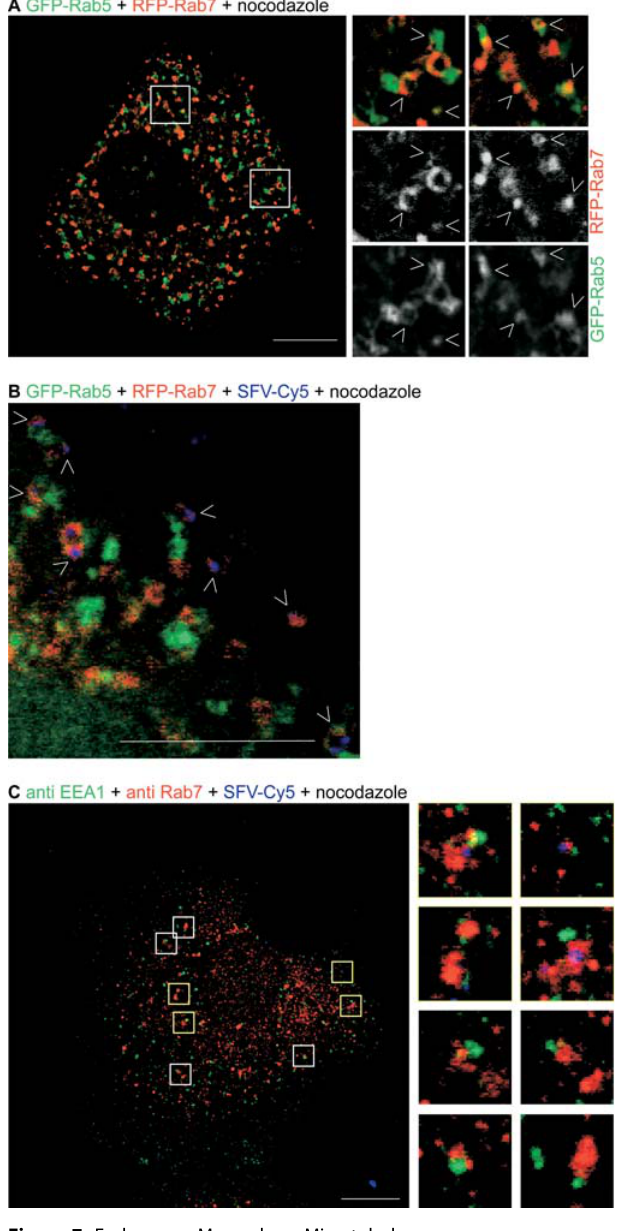
Figure 7. Endosomes Move along Microtubules (A) Confocal microscopy of a Vero cell transfected with GFP-Rab5 and RFP-Rab7 after treatment with 5 l M nocodazole. Endosomes are enlarged and many (approximately 75%) Rab5-positive endosomes are also positive for Rab7 (arrowheads). Scale bar represents 10 l m. (B) Cells treated as in (A) were incubated with SFV-Cy5, and fixed 1 h after warming. SFV-Cy5 is present in bigger endosomes positive for Rab5 and Rab7 (arrowheads). Scale bar represents 5 l m. (C) Confocal microscopy of a Vero cell treated with 5 l M nocodazole and incubated with SFV-Cy5. After 1 h of internalization at 37 8 C, cells were fixed, permeabilized, and immunostained for EEA1 and Rab7. Endosomes positive for both markers can be seen (white rectangles) (41%), and SFV- Cy5 is captured in these structures (yellow rectangles). The protrusions of Rab5 shown in (A) are not seen in (C) and are probably caused by overexpression of the Rab proteins. Scale bar represents 10 l m. DOI: